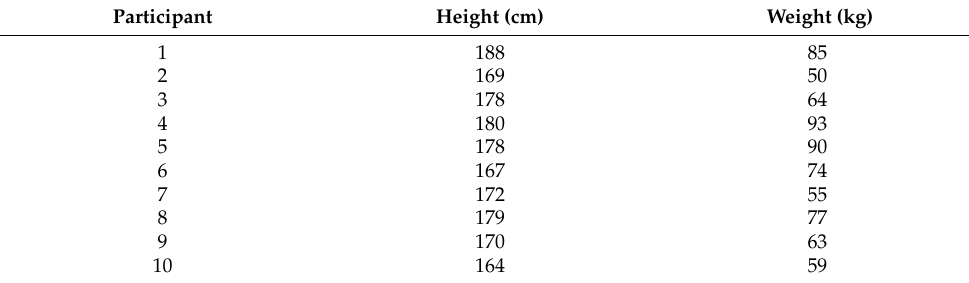
Table 3. Weight and height of participants in the RaDA dataset.